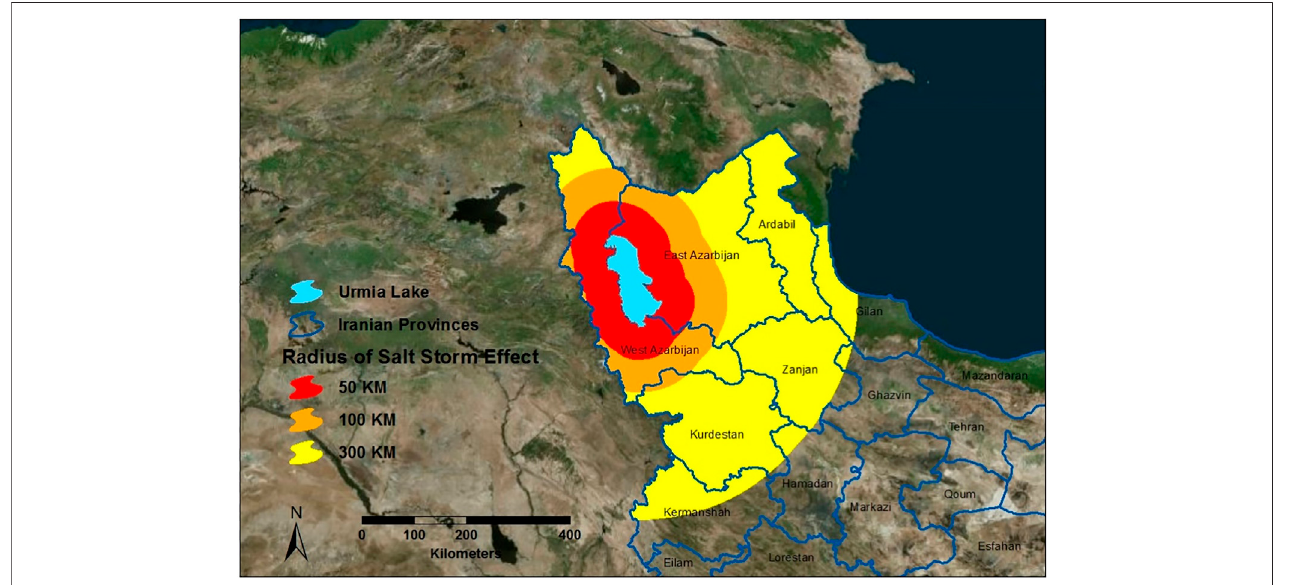
FIGURE 8 | Radius of Salt Storm Effect using ULRP reports (2014) (author ’ s illustration).